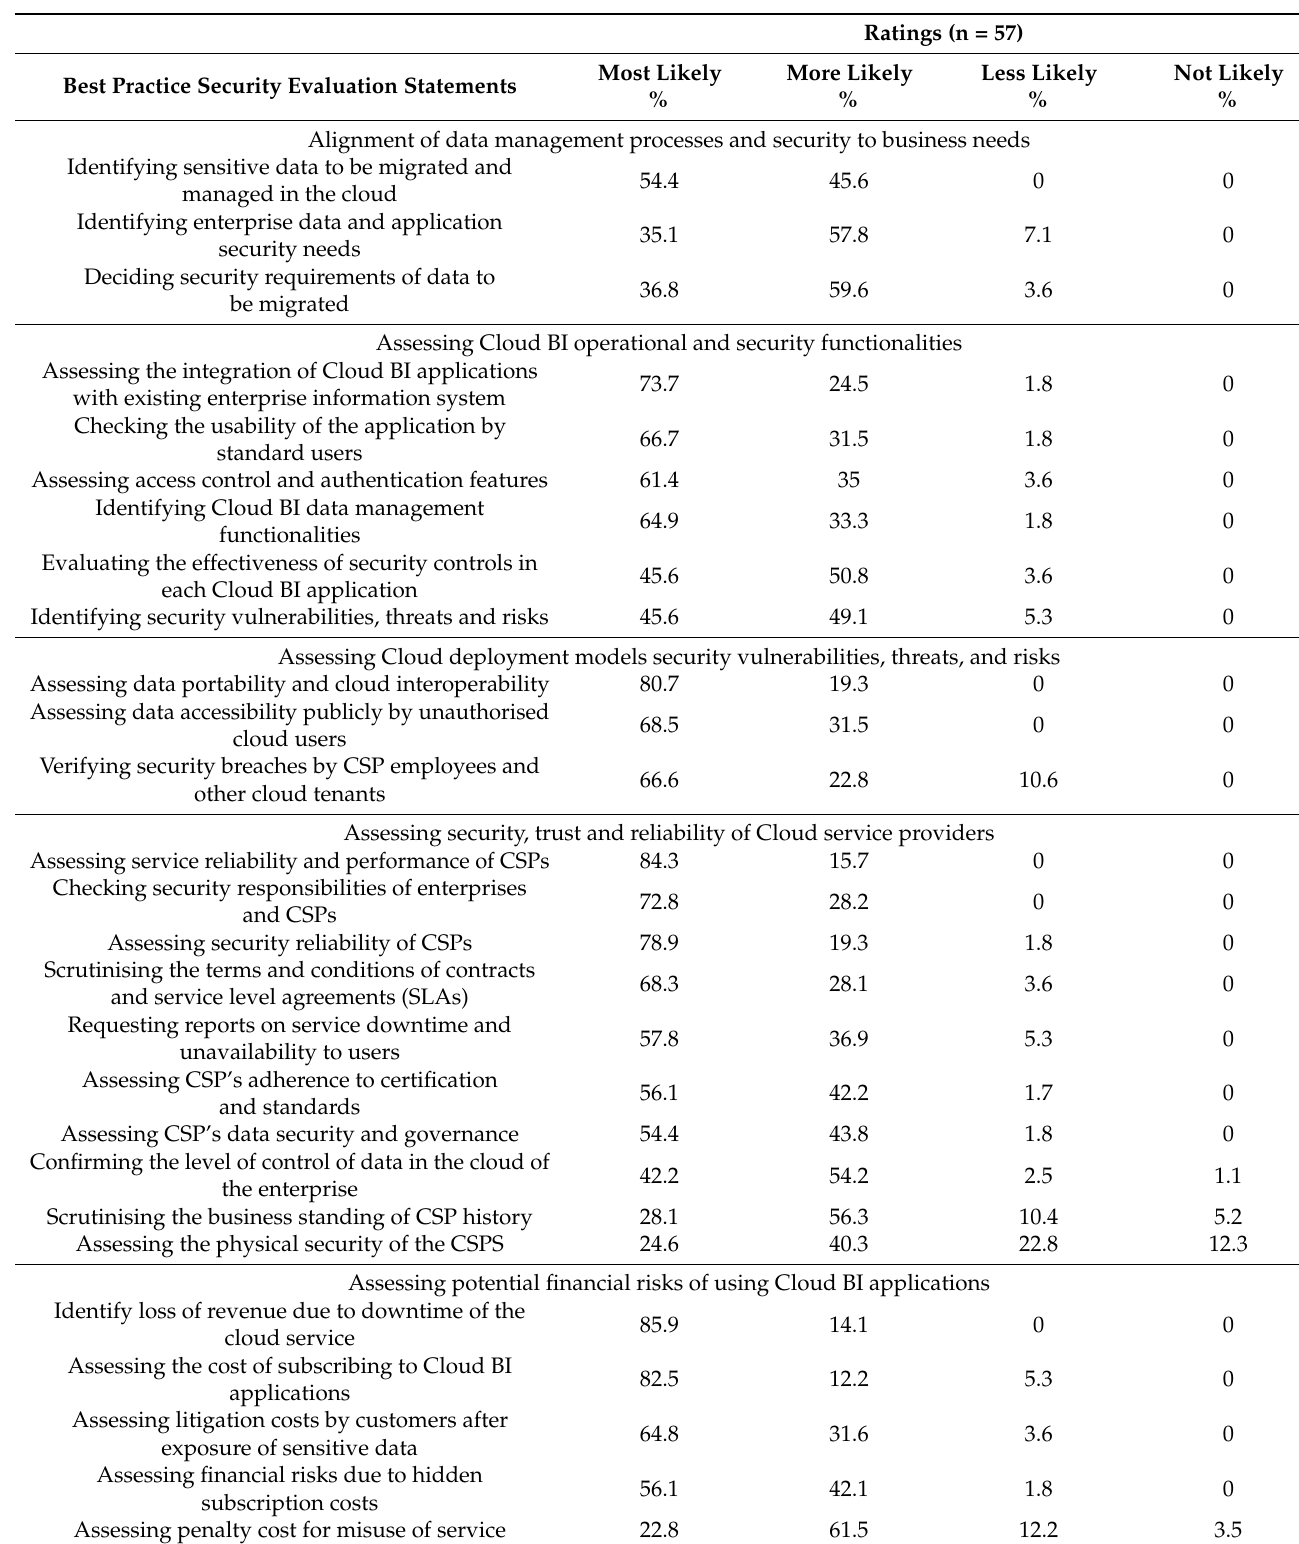
Table 4. Likelihood of using existing best practices in evaluating Cloud BI applications for adoption.